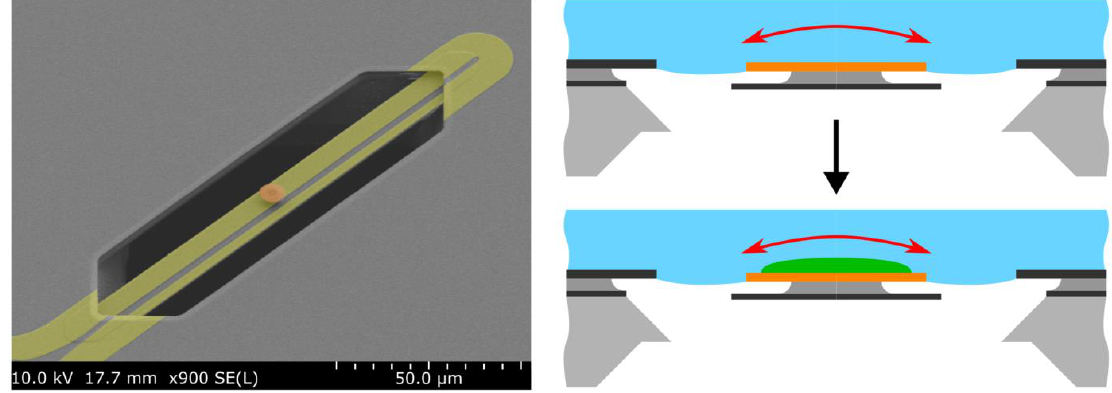
Figure 1. Left : False colored scanning electron microscopy image of the hybrid bridge microresonator [36]. Right top: Schematic cut view through the resonator bridge (black) and sensor plate (colored orange) single sided wetted by water (blue). Basic torsional mode of the bridge indicated by red arrow. Right bottom: Functionalization by hydrogel (green).